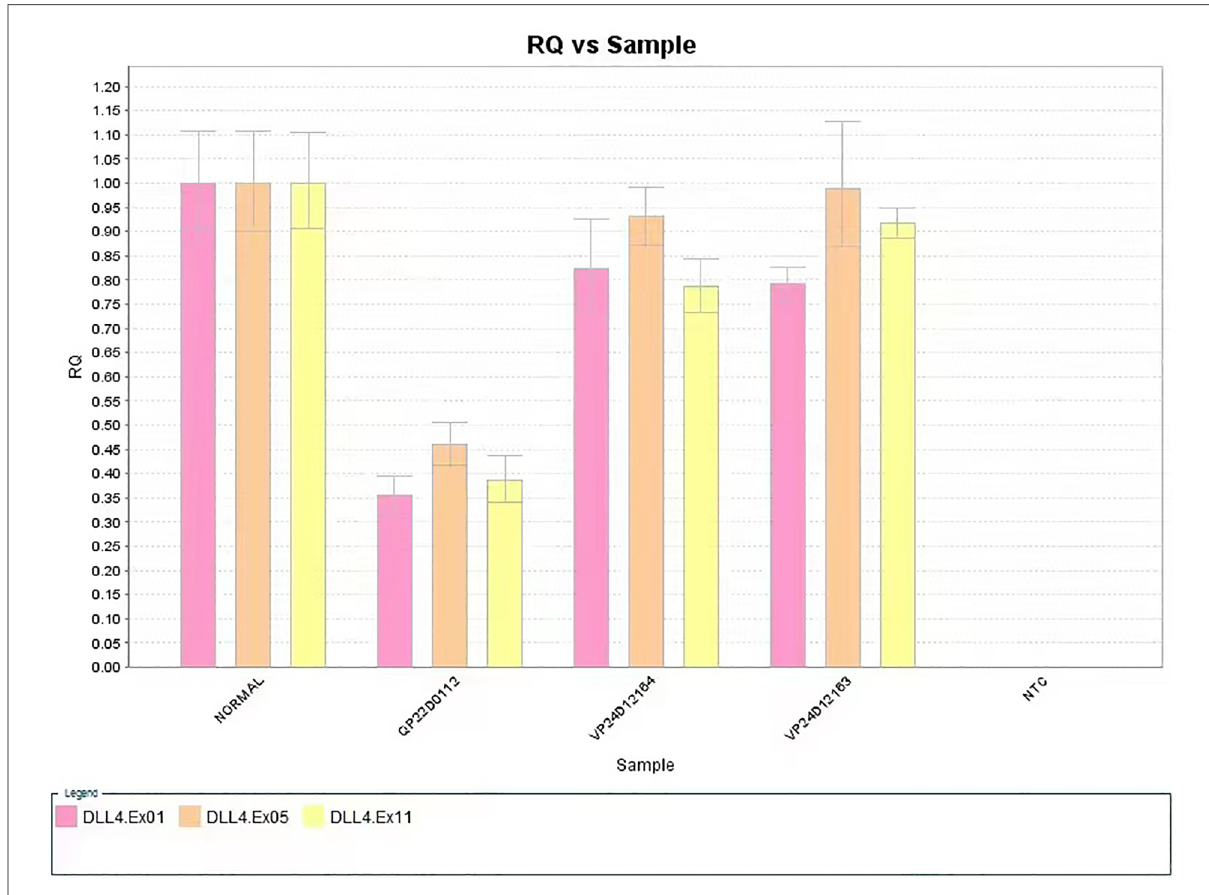
FIGURE 2 The large deletion of exon1, exon5, and exon11 of the DLL4 gene of the case study infant (sample no. QP22D0112, the patient; Sample no. VP24D12164, the patient ’ s father; Sample no. VP24D12163, the patient ’ s